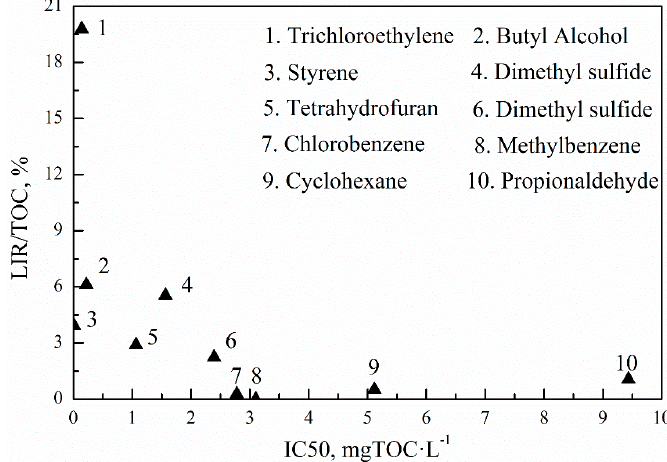
Figure 2. Luminescent inhibition ratio (LIR)/TOC and half maximal inhibitory concentration (IC50) of luminescent bacterium for 10 VOCs, including off-gas absorption solutions.